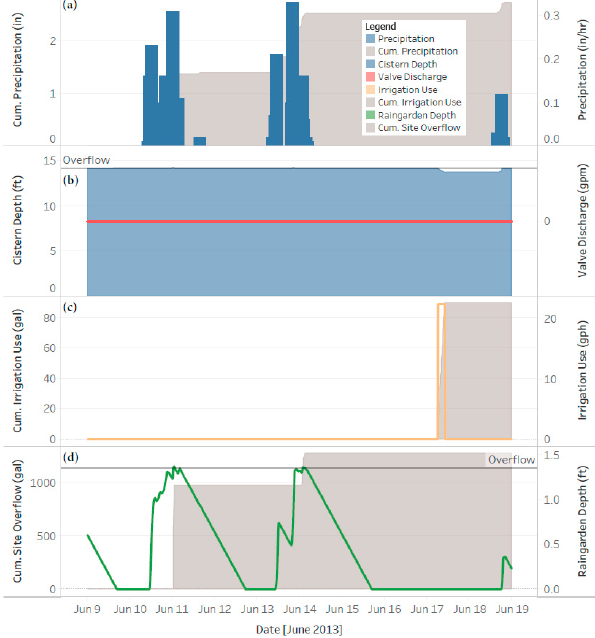
Figure 4. Moisture Scenario Performance (9 June 2013–19 June 2013): ( a ) Rainfall occurred on 10 June 2013 and 13 June 2013; ( b ) The cistern’s water level decreased once on 17 June 2013 from moisture based irrigation and overflowed to the raingarden during both rainfall events; ( c ) Moisture based irrigation occurred once on 17 June 2013; ( d ) The raingarden overflowed to the site outfall during both rainfall events despite beginning each event entirely empty.